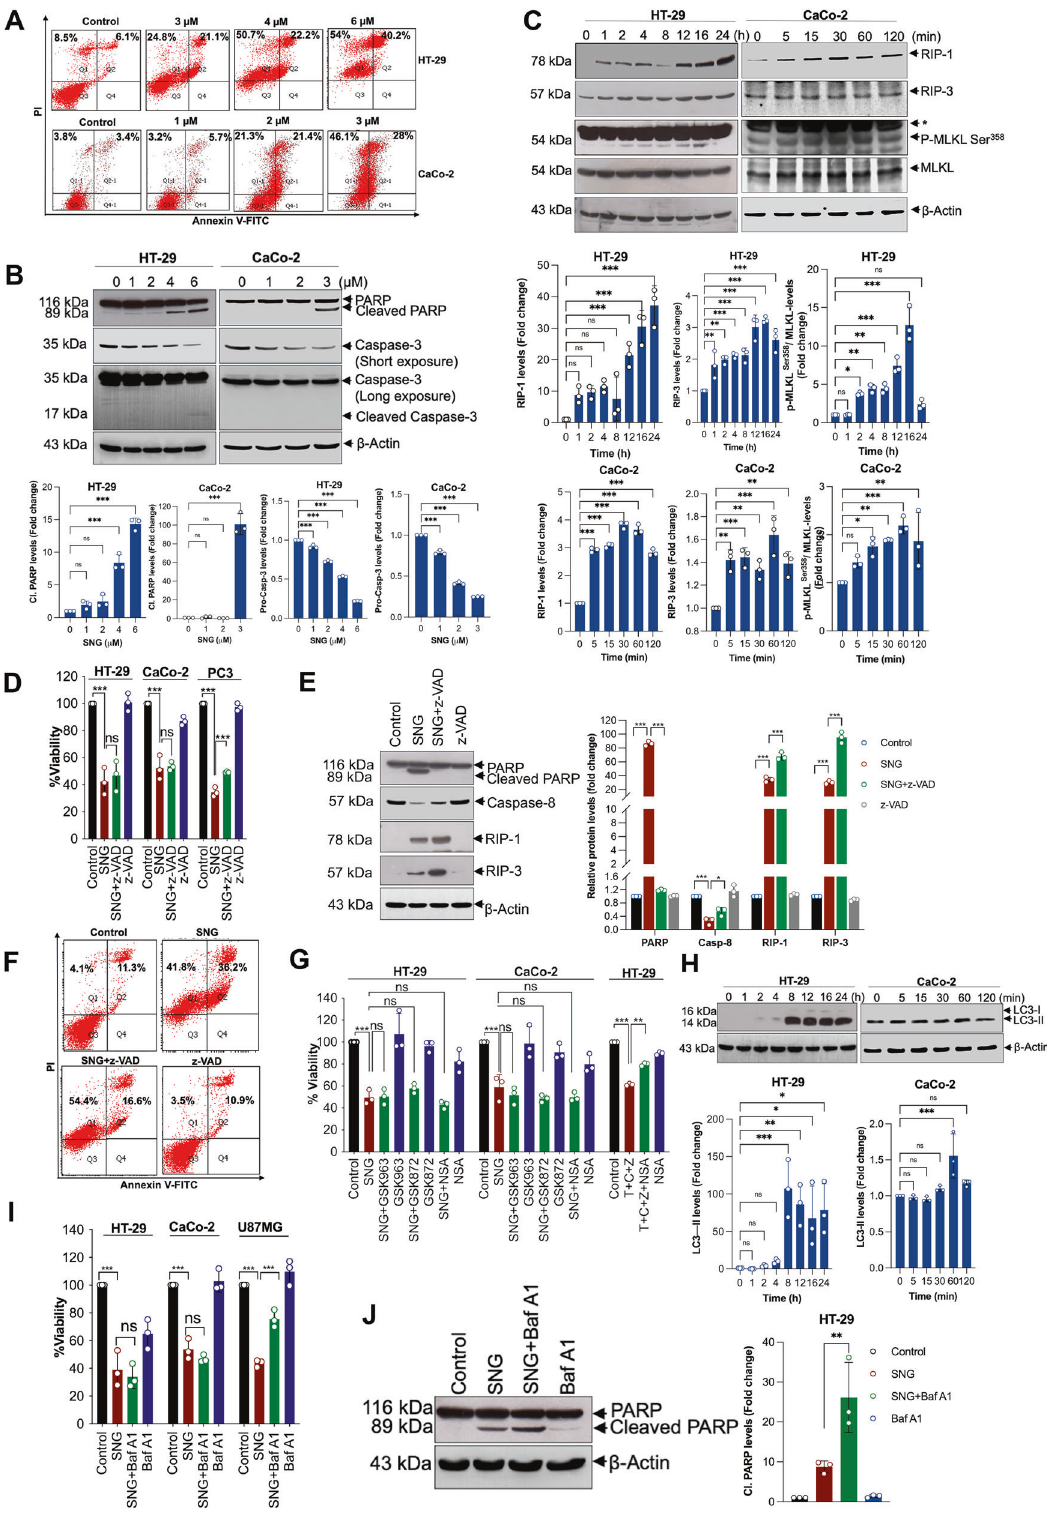
xenografts demonstrated dephosphorylation of AIFM1 at Ser 116